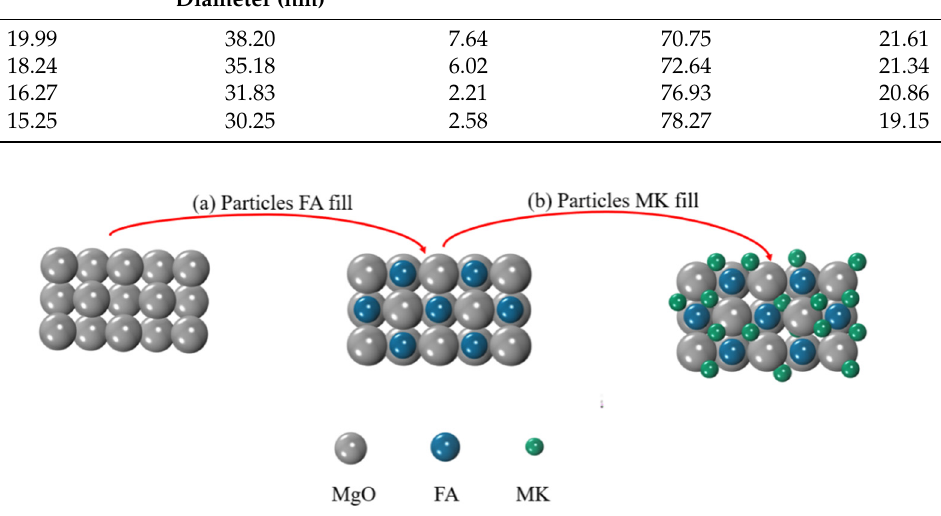
Figure 12. Scheme depicting the filling effect of FA and MK on MOSC samples: ( a ) filling with FA particles; ( b ) filling with MK particles.